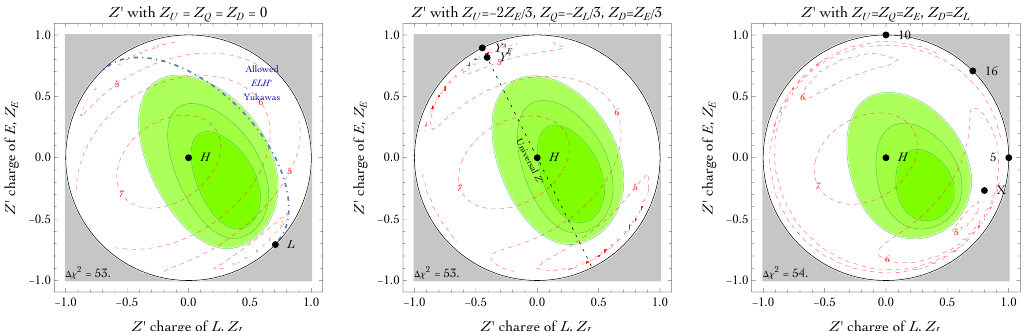
Figure 4. Extra Z 0 that fit electroweak data, including the M W anomaly. The Z 0 effects dominantly depend on the Z 0 charge of the Higgs and the leptons: we here assume the normalization Z 2 = 1 such that Z = 0 at the boundary of the circles, and Z Z 2 H H panels assume different sets of quark charges, and show similar results. The green contours show the best-fit regions at 68% and 90% confidence levels. The red dashed contours show the best-fit values of M in TeV . The dashed line in the middle panel corresponds to a universal Z 0 and Z 0 /g Z 0 the dot-dashed curve in the first panel to a Z 0 compatible with the SM LEH ∗ lepton Yukawas. The dots show some Z 0 s listed in table